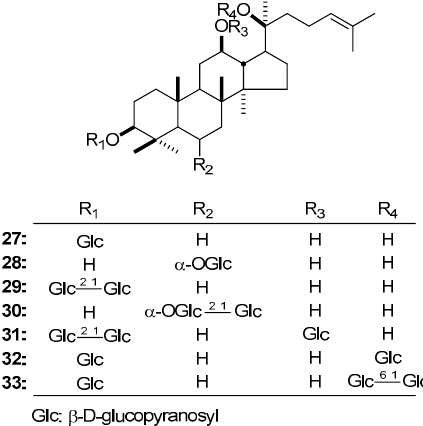
Figure 4. The structure of compounds 27 – 33 .